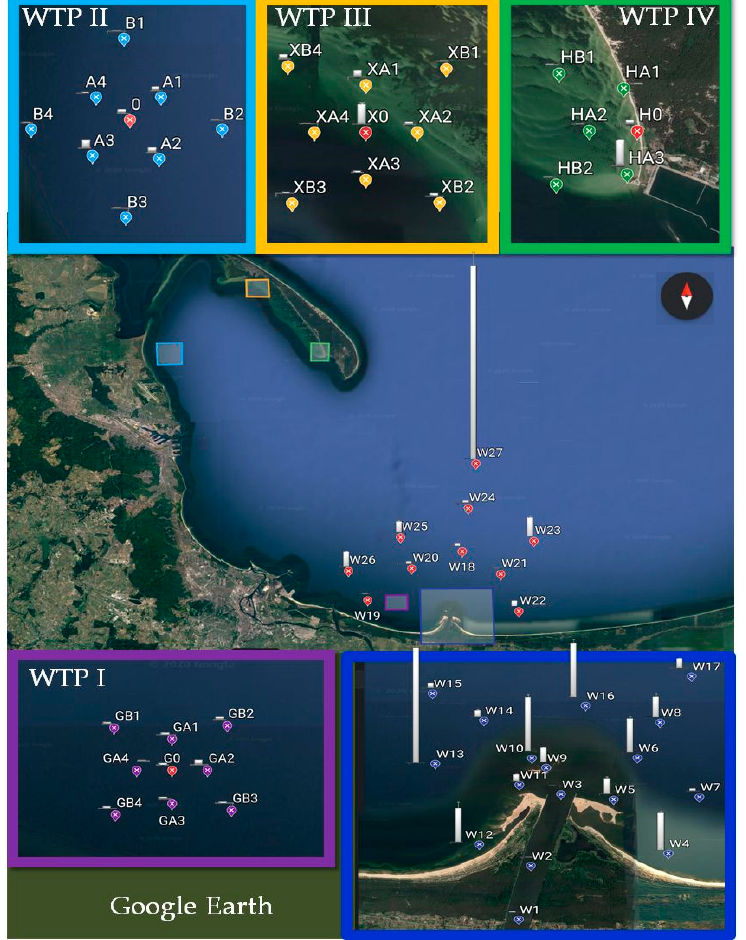
Figure 2. The results of the determination of PFASs in samples taken around the sewage collectors’ outlets from wastewater treatment plants (WTP I-WTP IV) and from the mouth of Vistula. In the case of samples taken at the mouth of the Vistula, the highest concentrations of Σ PFASs were observed for points W13 and W27 (350 ± 20 and 614 ± 46 ng/g d.w., respectively). The content of PFHxS in these samples had influence on the above mentioned results (Figure 2, Figure S2). The lowest level of Σ PFASs was found in the samples collected at W2 (0.509 ± 0.017 ng/g d.w.), W3 (0.79 ± 0.11 ng/g d.w.), and W21 (0.98 ± 0.12 ng/g